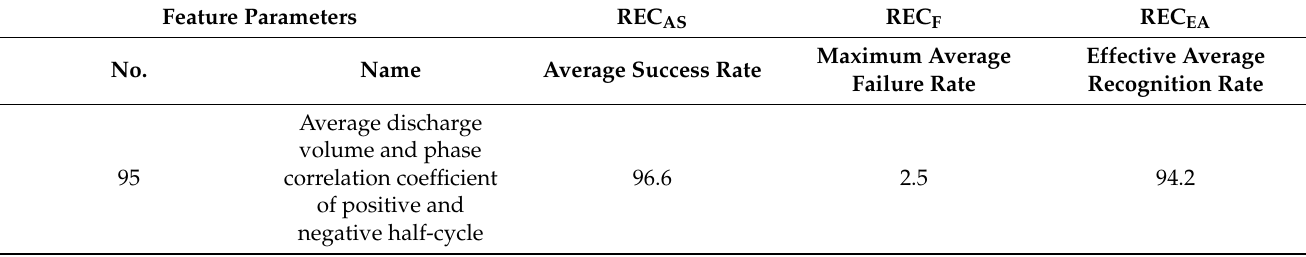
Table 11. GIS-2 best recognition rate of the characteristic parametric: cross-correlation coefficients.